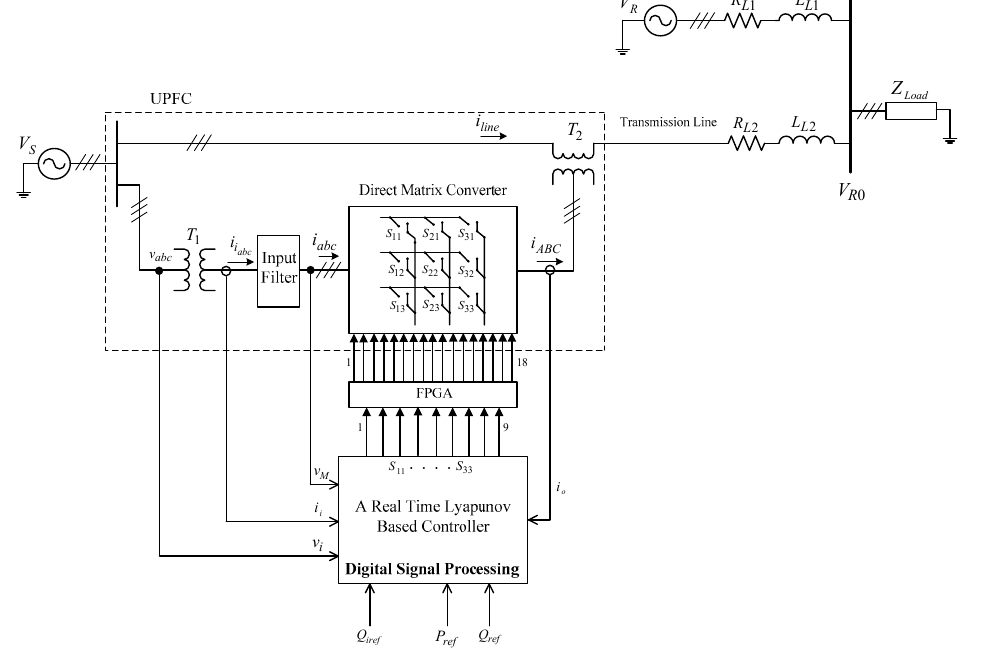
Figure 4. Control scheme of the real time Lyapunov-based controller of the DMC-UPFC.